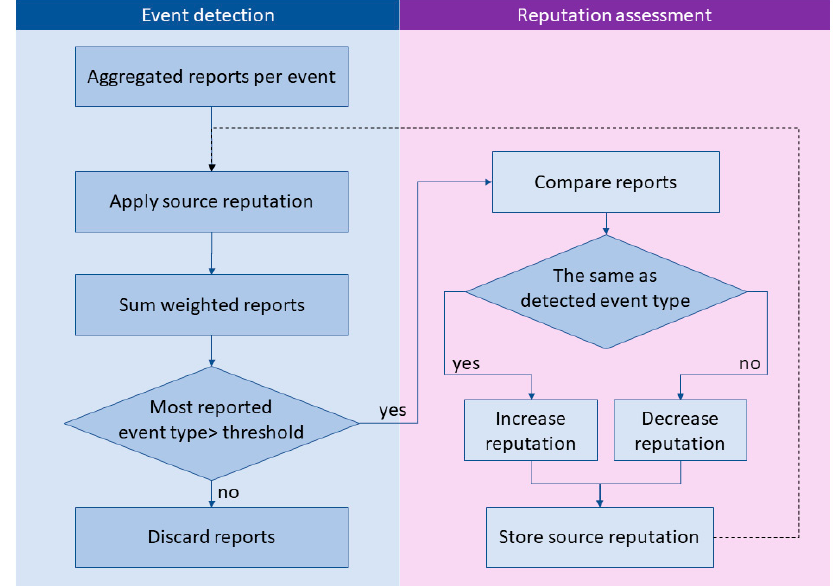
Figure 3. Event detection mechanism: Weighted majority voting.